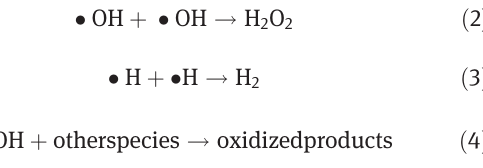
Figure 4: SEM images of MnOOH prepared in the presence of different amounts of SDS: (a) sample no. 4, (b) sample no. 5, (c) sample no. 6 and (d) sample no.